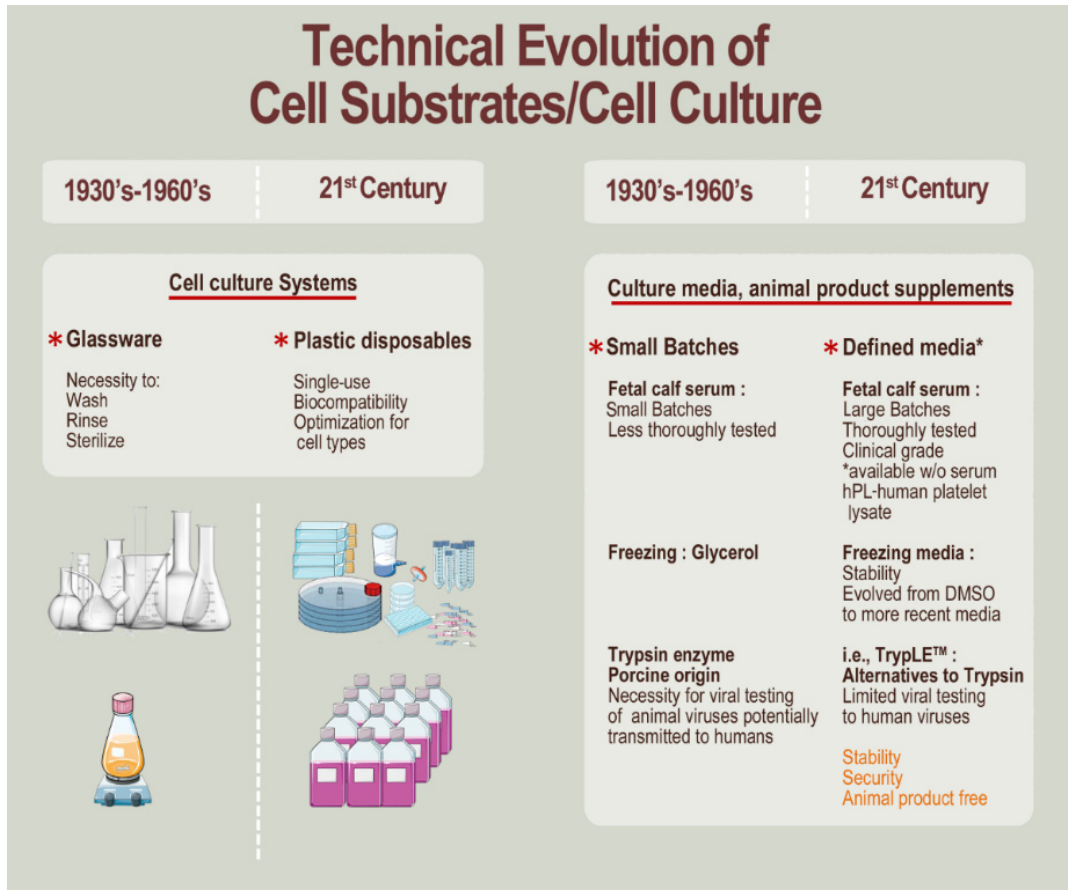
Figure 1. Technical evolution of cell culture conditions for vaccine substrates or biological API maintenance, processing, and storage from the 1930s–1960s era to the 21st century. Cell culture systems have evolved from cumbersome glassware requiring extensive washing, rinsing, and sterilization (i.e., trace elements impregnated in old glass) to single-use, disposable plastics that can be optimized and specifically comparatively tested for cytocompatibility. Culture growth and freezing media have evolved in terms of composition and quality, with extensive testing and qualification of larger batches and elimination of animal-sourced products, with the overall goal of increasing security and limiting biosafety-related risks for the considered manufacturing process and eventual clinical application of cell-based products. API, active pharmaceutical ingredient; DMSO, dimethyl sulfoxide; hPL, human platelet lysate.